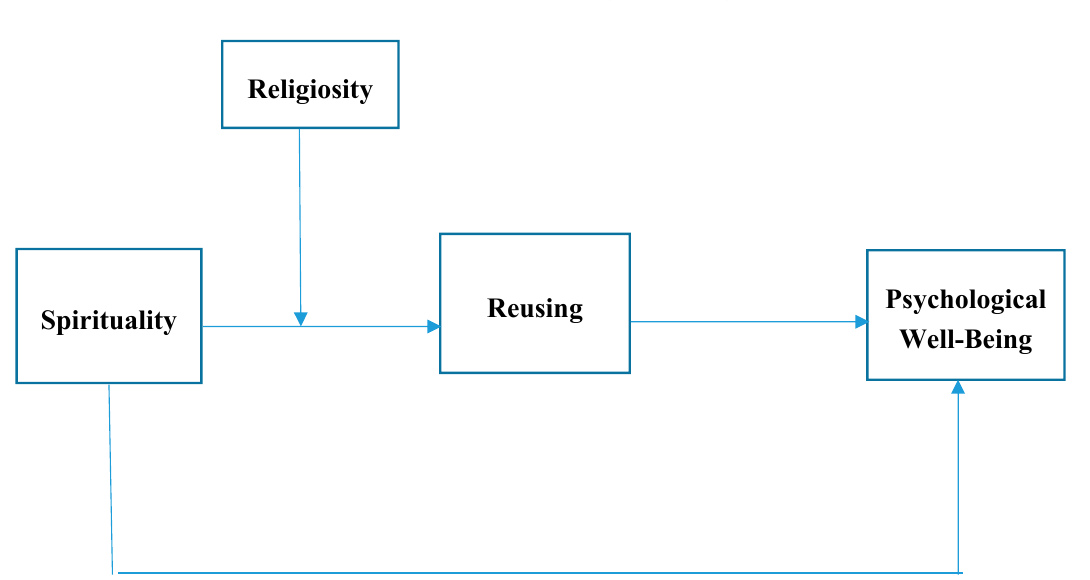
Figure 1. Graphical Representation of Theoretical Framework.